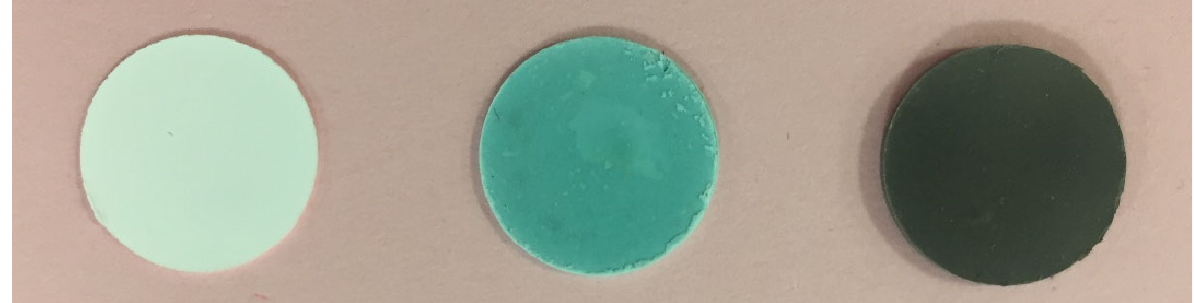
Figure 3. Zeolite samples pressed into pellets: parent zeolite MOR ( left ), MOR-Cu(NO 3 ) 2 before activation ( middle ), and MOR-Cu(NO 3 ) 2 after activation ( right ).